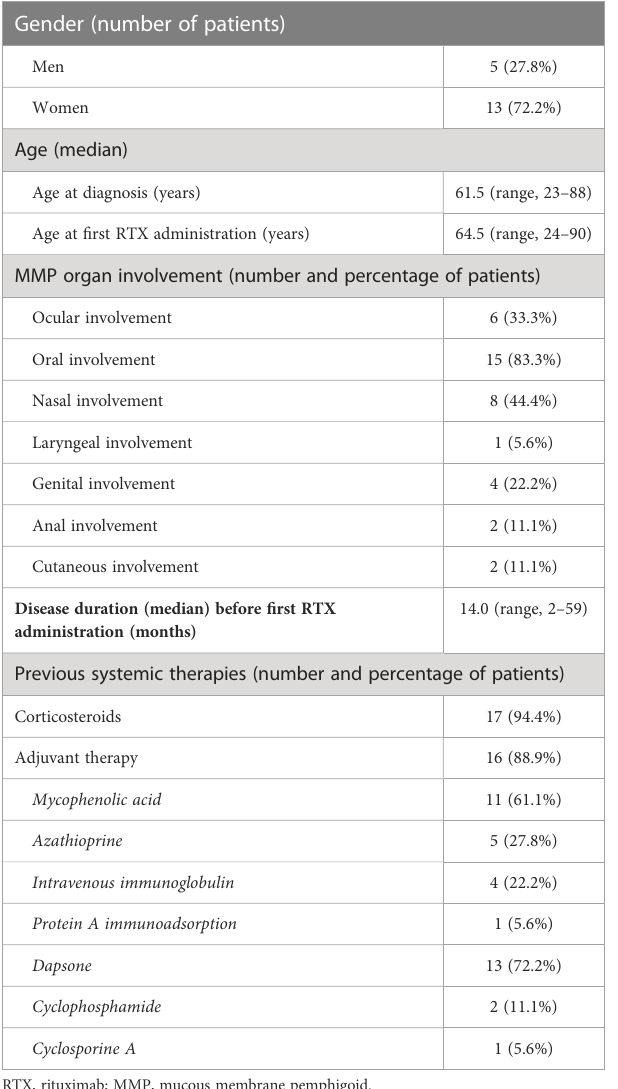
TABLE 1 Demographics, organ involvement, and therapies prior to RTX.